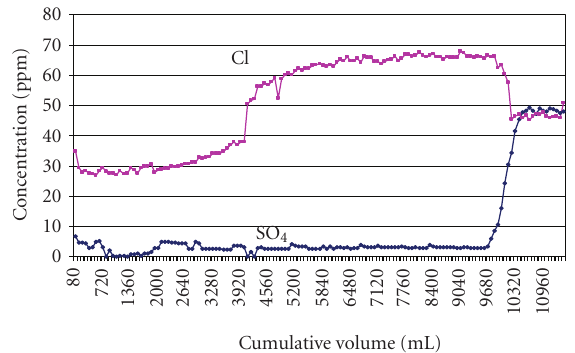
Figure 9: Breakthrough results using 50 ppm SO 4 and Cl.